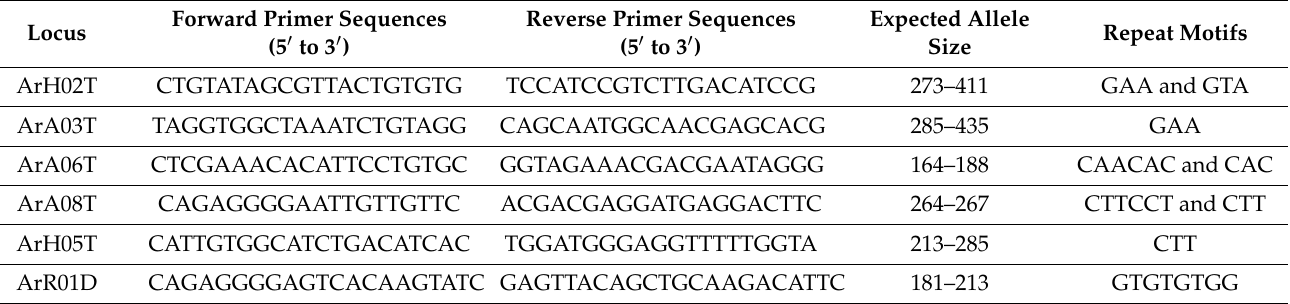
Table 1. Characteristics of six polymorphic microsatellite markers in the current population genetic diversity study of D. rabiei. Forward Primer Locus